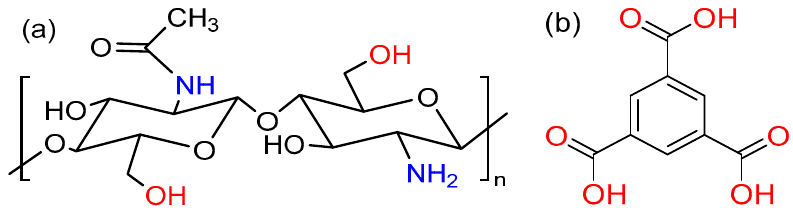
Figure 1. Structures of ( a ) chitosan and ( b ) 1,3,5-benzene tricarboxylic acid (BTC).